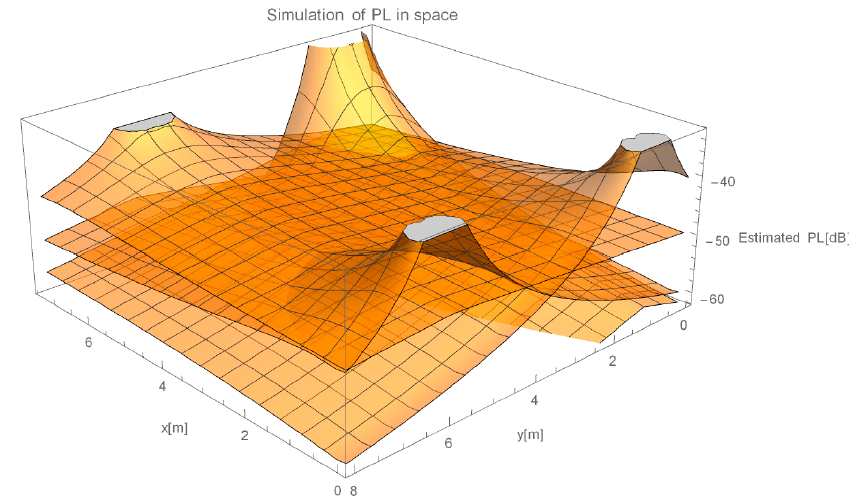
Figure 11. Output from propagation simulation stage of the method—simulation of path loss in the evaluating space emitted by four APs.